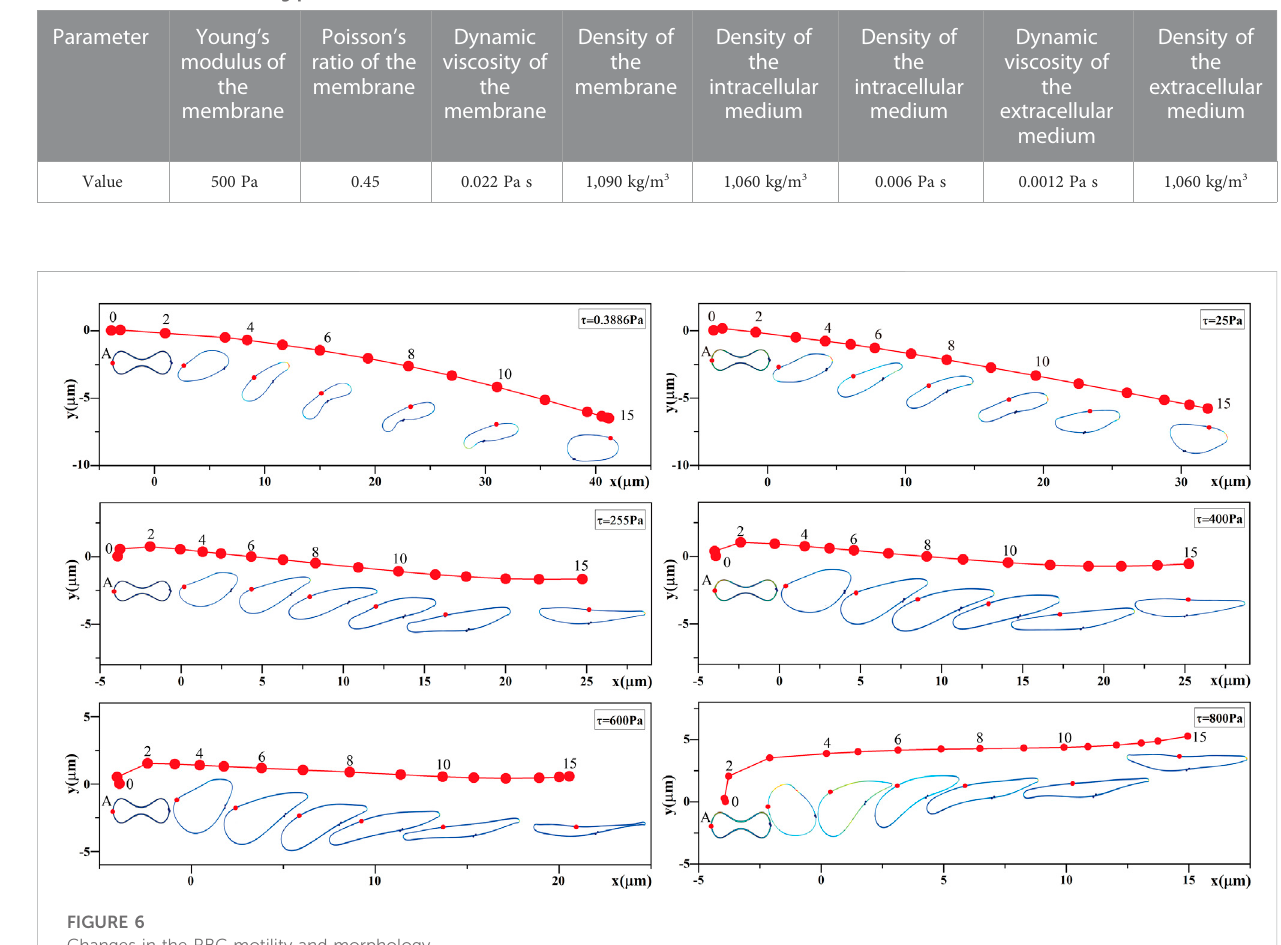
FIGURE 6 Changes in the RBC motility and